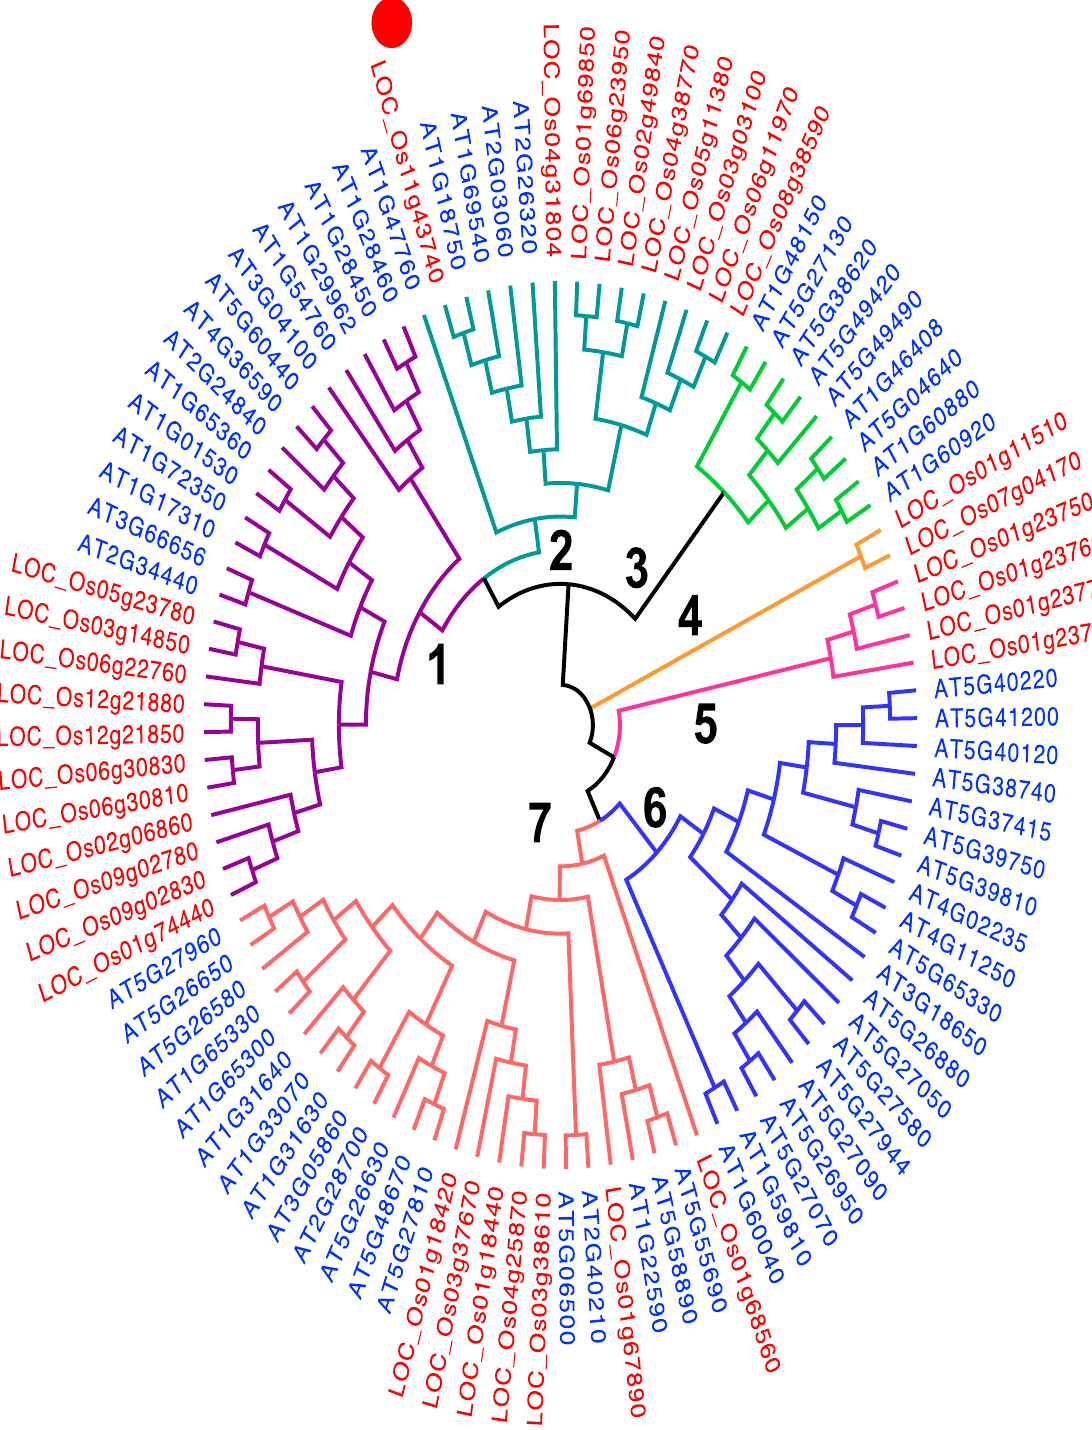
Figure 2. Phylogenetic tree of collated rice and Arabidopsis full-length MADS-box protein sequences. Red dots represent the rice-Arabidopsis orthologous gene pairs. The tree is built using the neighbor-joining (NJ) method (MEGA7.0 software) and are divided into seven clades, numbered in